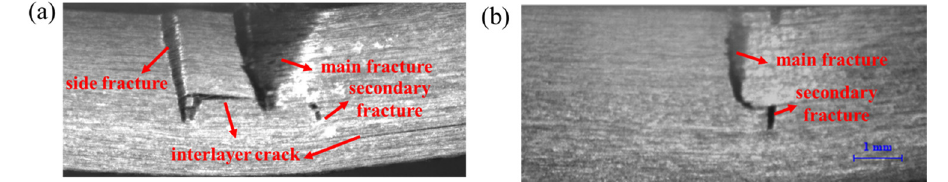
Figure 8: Macroscopic failure process through lateral surface of ( a ) composite and ( b ) Z - pin composite under three - point fl exural load after 7 day immersion with 60% fl exural load.